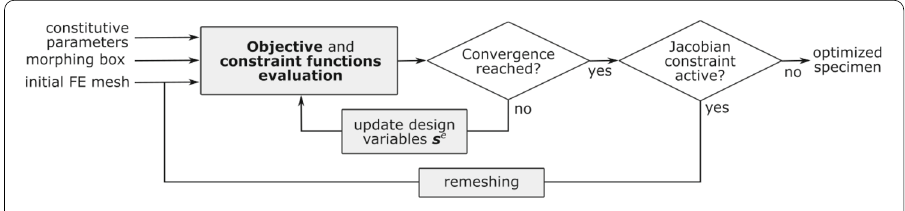
Fig. 4 Flowchart of the proposed spline-based optimization process to improve a specimen shape with respect to identification uncertainty